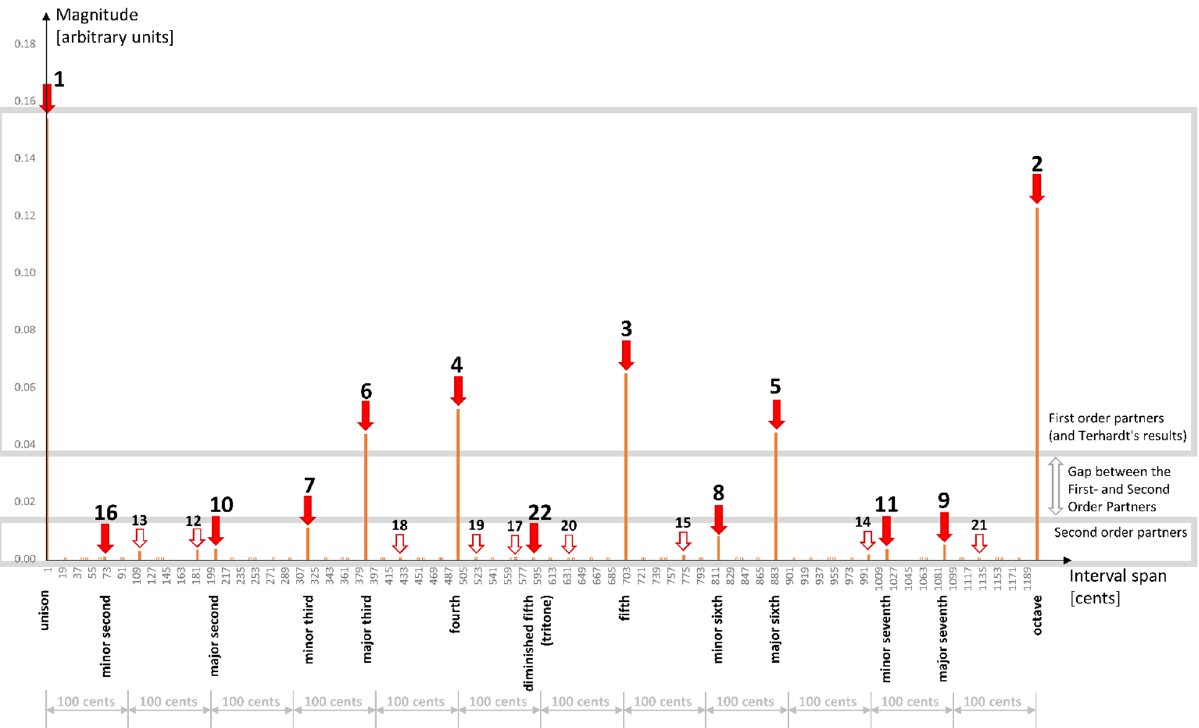
Figure 7. Graphical representation of the obtained comparison results. Sourced from Fig. 3, this figure shows a bar graph of magnitudes of the emerged intervals against the interval span dimension. The graph clearly resembles Fig. 2, demonstrating the discrete nature of the emerged intervals and the approximate invariance of that discreteness on the used input frequency resolution. Also, compared to Fig. 2, one can observe that the consonance pattern of the most consonant intervals is preserved as per our previous study 11 . The number annotations above the arrows show the order of the emerged interval in the list order by decreasing magnitude (lower numbers represent more consonant intervals). The filled arrows point to the matching Helmholtz’s list intervals as per Fig. 3. The empty arrows point to the intervals that our model yielded as more consonant than 16th or 22nd. The upper grayed area contains the First-Order Partners (highly consonant intervals). The lower grayed area contains the Second-Order Partners (less-consonant intervals); the wide gap between the First-Order Partners and Second-Order Partners magnitudes is observable. The intervals that emerged from Terhardt’s model are all in the zone of the First-Order